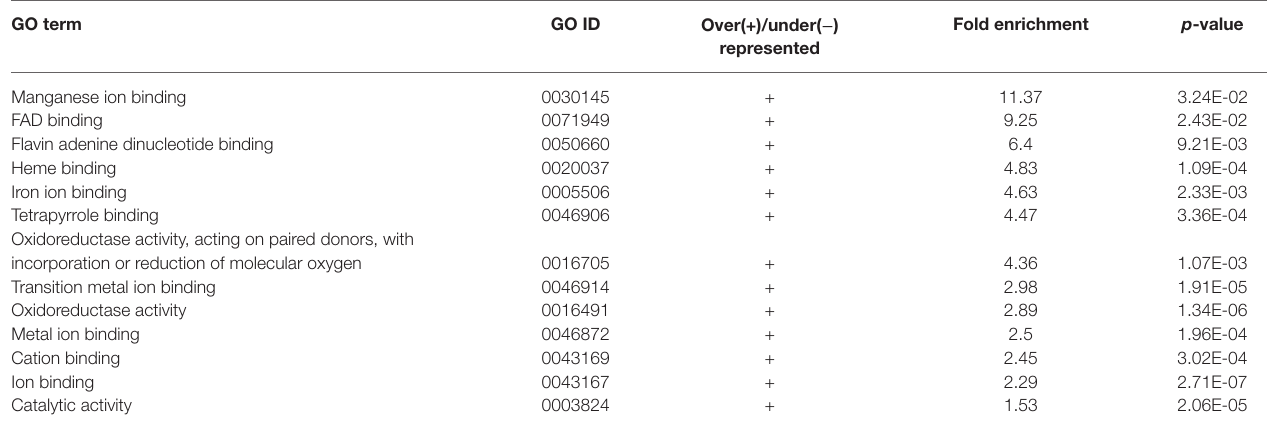
Fold enrichment p -value represented